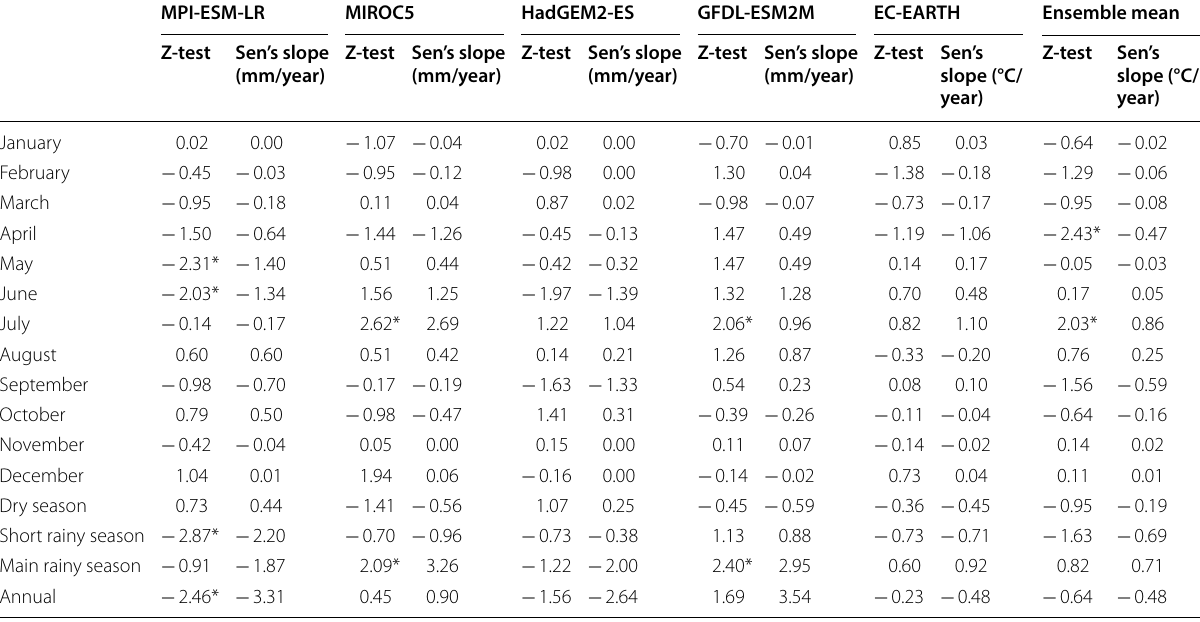
* Statistically significant at 0.05% level Table 6 Mann–Kendall and Sen’s slope results for projected maximum temperature trends